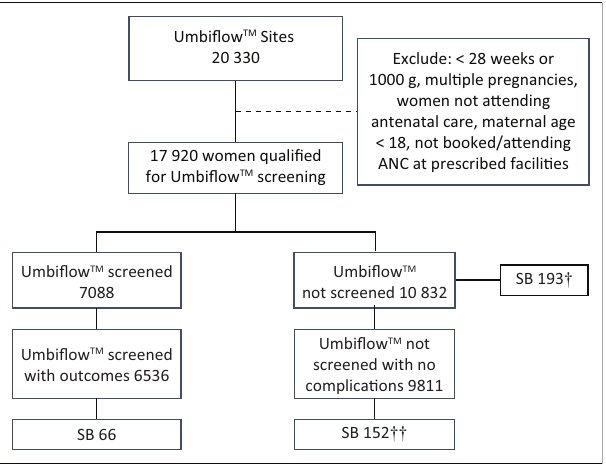
FIGURE 2: Flow chart of women included in the study.